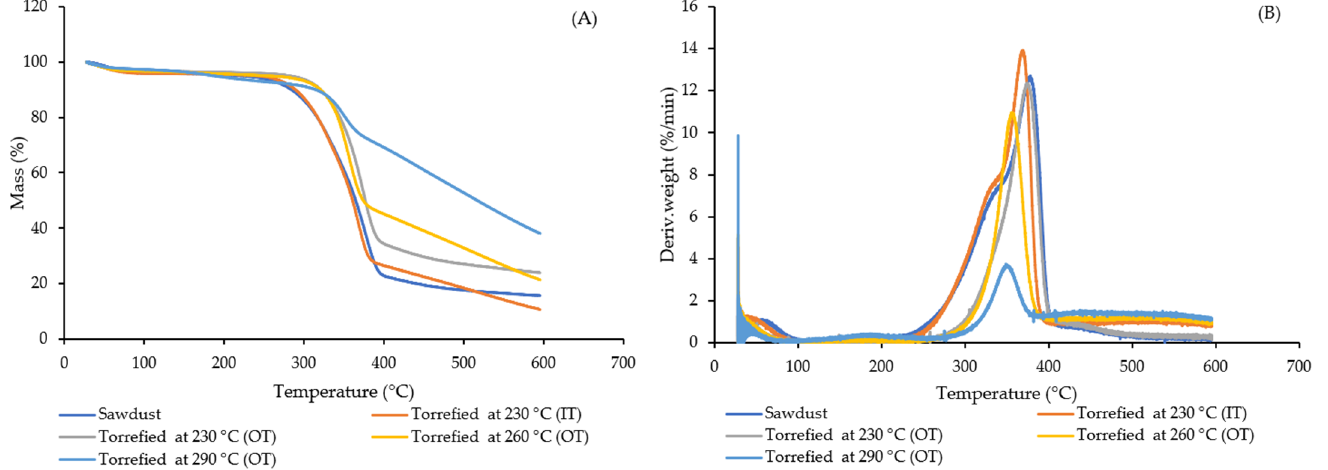
Figure 5. TGA results of raw and torrefied wood sawdust ( A ) indicate mass loss and ( B ) decompo- sition rate during thermal heating. tion rate during thermal heating.